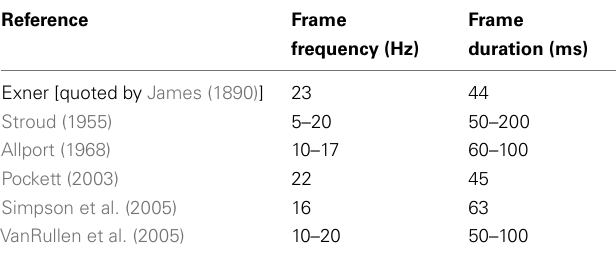
Table 2 | Frequencies of frames of visual consciousness in psychological